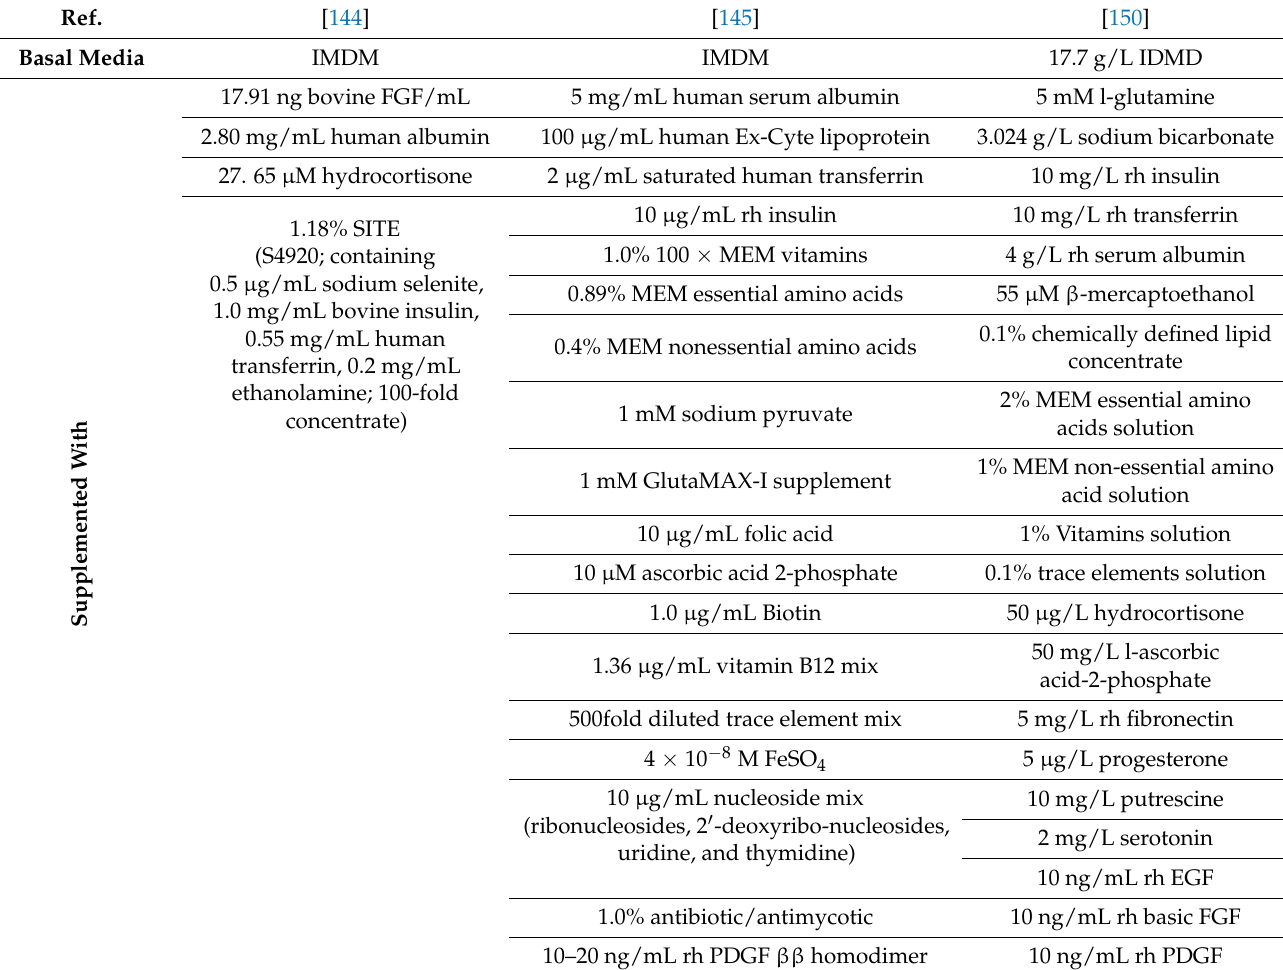
Table 3. Composition of three disclosed chemically defined cell culture media for MSCs.